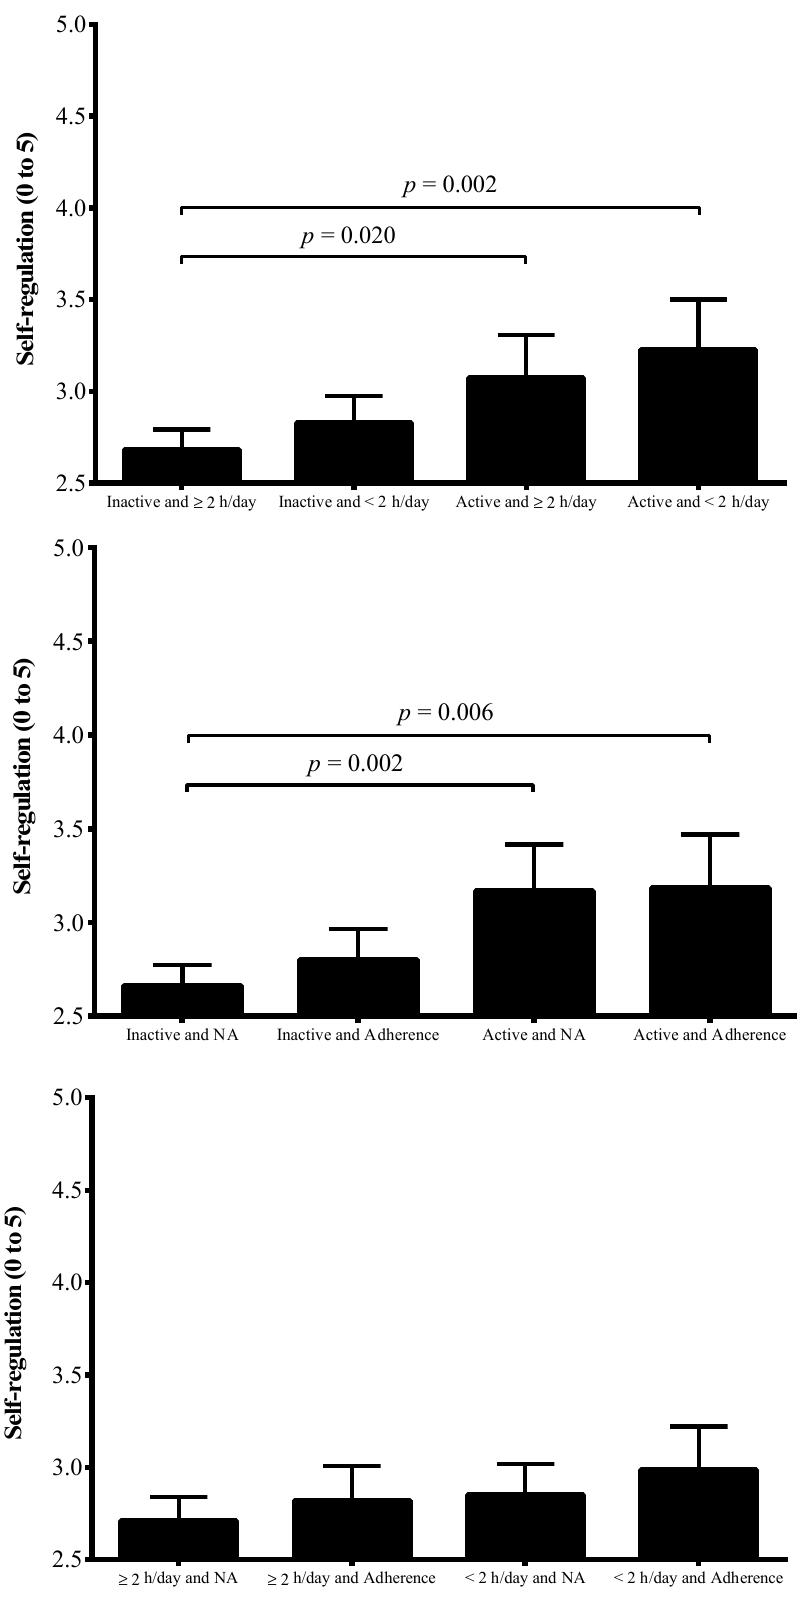
Figure 3. Di ff erences in mean values of self-regulation across combined groups of physical activity, screen time, and Mediterranean Diet. NA, non-adherence to the Mediterranean